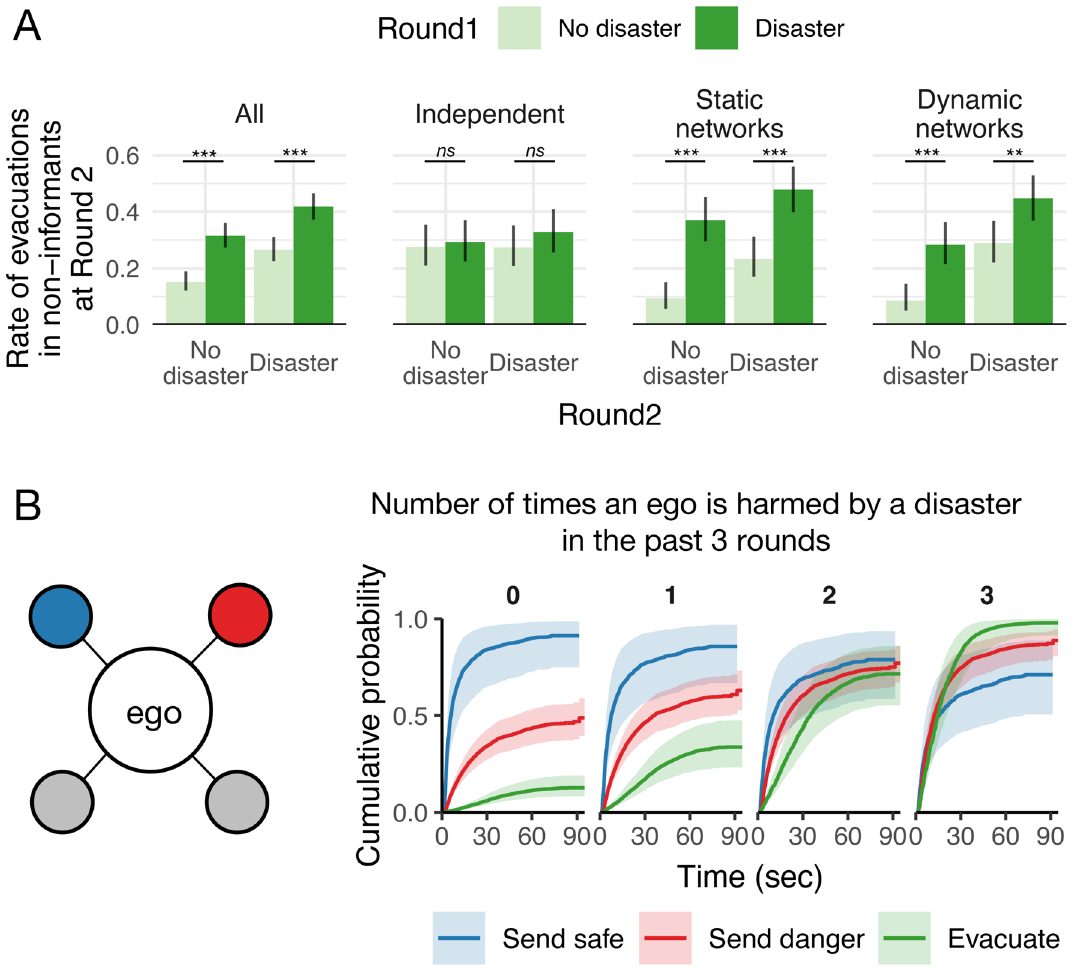
Figure 3. “Disaster” experience increases individual responsiveness. ( A ) The rate of evacuations in non- informants at the second round across “disaster” events at the first round. Error bars are 95% confidence intervals with Wilson method ( n = 429.3 (s.d. = 3.5) for all the conditions, n = 145.3 (s.d. = 1.7) for the independent condition, n = 142.8 (s.d. = 4.9) for the static-network condition, n = 141.3 (s.d. = 1.7) for the dynamic-network condition). ns indicates P ≥ 0.05, ** indicates P < 0.01, *** indicates P < 0.001 with two proportion z -test. ( B ) Lines present the estimated probability of taking action at a given time if a player continues to receive the signal combination from neighbors shown in the left diagram (a player indicated by “ego” follows four other players; one neighbor keeps showing safe, another showing danger, and the other two showing no signals). Shading indicates 95% confidence intervals among individuals. The cumulative probabilities depend on how many times the player has been affected by a “disaster” in the past three rounds. As individuals experience “disaster,” they increase the probability of sending a warning and evacuating upon exposure to more warnings than safe messages. The neighborhood sample is arbitrarily selected to show the changes in individual responsiveness while controlling for signal exposure from neighbors. See the statistical models and results in “Methods” and Supplementary Table Isolated effects of network structure. Finally, I examined the isolated effect of network structure that subjects developed in the dynamic network condition. In a supplementary experiment involving 567 additional, inexperienced subjects and a matched set of 40 graphs, they played a single-round evacuation game in the same network topology, informant’s node, game length, and disaster occurrence as other subjects had played at round 4 in the dynamic network condition (Fig. 4A). I found that network structure alone did not contribute to the improvement in collective intelligence shown in the dynamic networks. Figure 4B shows that, in the sessions with disasters, the first-round performance of sub- jects interacting in the copied, isomorphic networks was significantly lower than the fourth-round performance of subjects interacting in the networks that they developed on their own ( P < 0.001; paired t test). Furthermore, there was no difference from the sessions of original networks at the first round ( P = 0.273; Welch two-sample t test), although the copied networks were denser, shorter, and more clustered, and informants were center in the networks (Fig. 4A). This finding suggests that social networks can only exert their positive structural effect on collective performance when the structure is based on the history of the individuals within them.